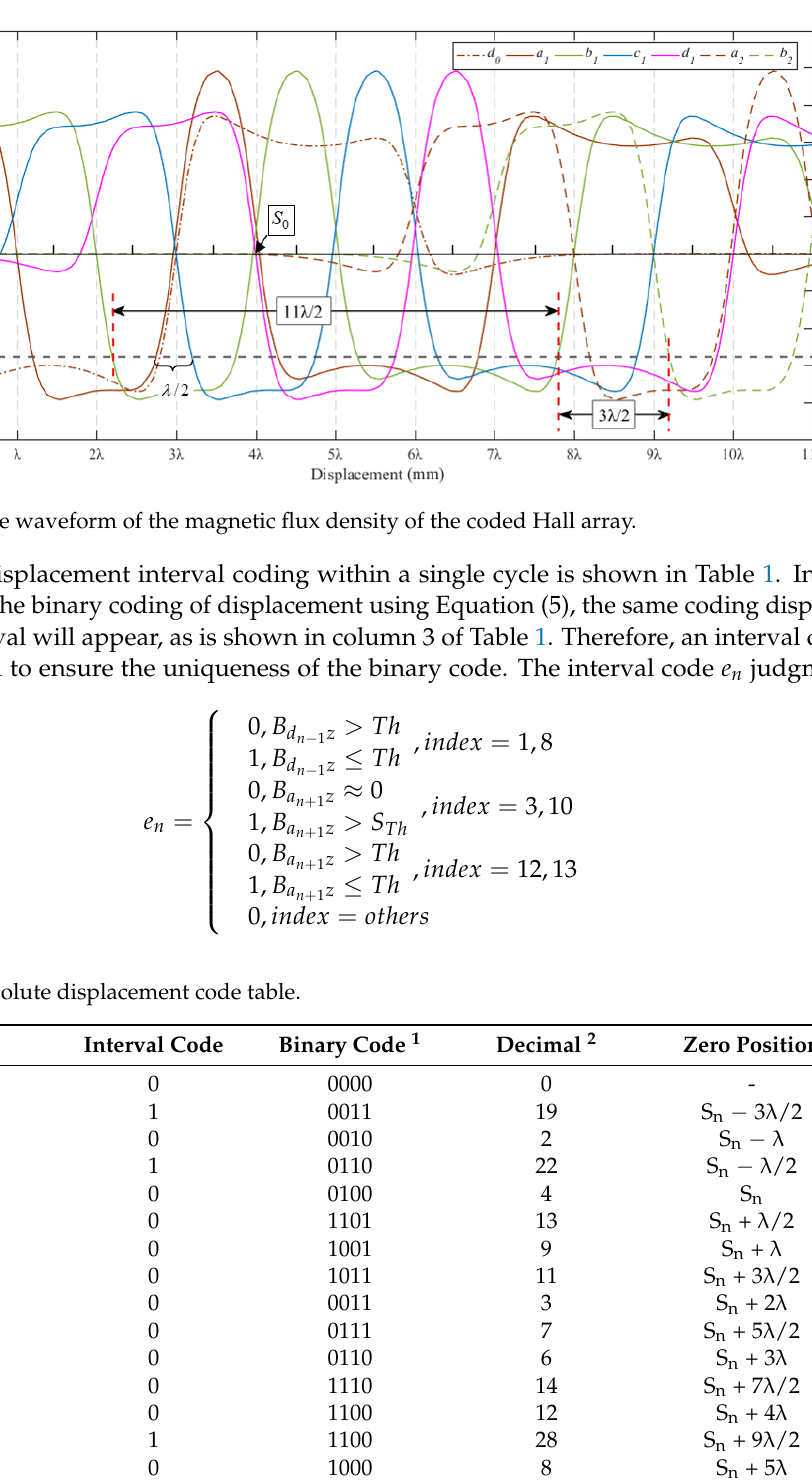
Table 1. Absolute displacement code table.